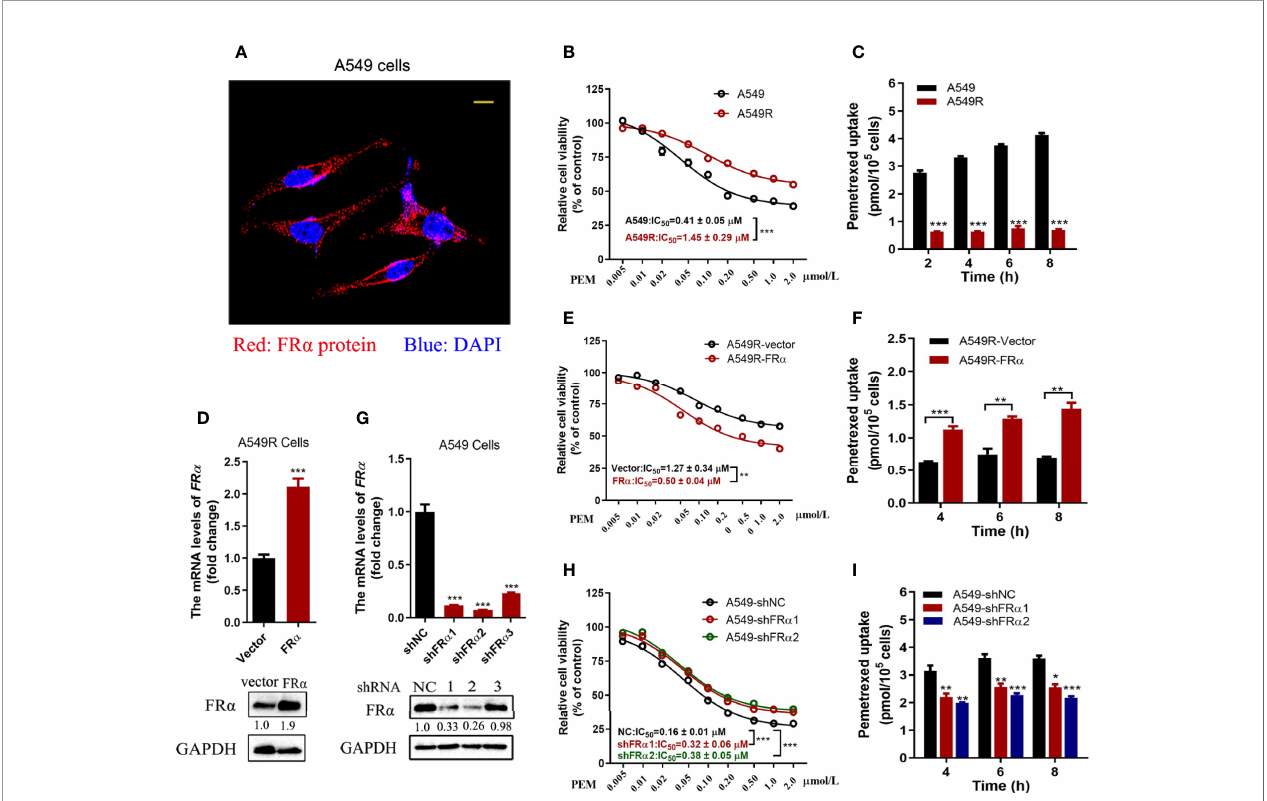
FIGURE 2 | Low FR a expression decreased the ef fi cacy of pemetrexed. (A) Confocal microscope image to determine the location of FR a in A549 cells. Bar = 10 m m. (B, E, H) Effect of pemetrexed on the viability of A549, A549R and their cell models. All cells were treated with pemetrexed at a concentration range of 0.005- 2.0 m M for 96 h and then evaluated with the CCK-8 assay. Data are expressed as mean ± SE, n =5. (D) Cell models in which A549R cells stably overexpressing FR a or (G) A549 with stable knockdown of FR a . (C, F, I) Cellular accumulation of pemetrexed (50 m M) in A549, A549R and their cell models over 2, 4, 6 and 8 h. Data are presented as the means ± SE, n =3. Differences between A549 and A549R cells, A549R-vector and A549R-FR a cells, A549-shNC and A549-shFR a -1/ shFR a -2 cells are denoted as: *p < 0.05, **p < 0.01, and ***p < 0.001,